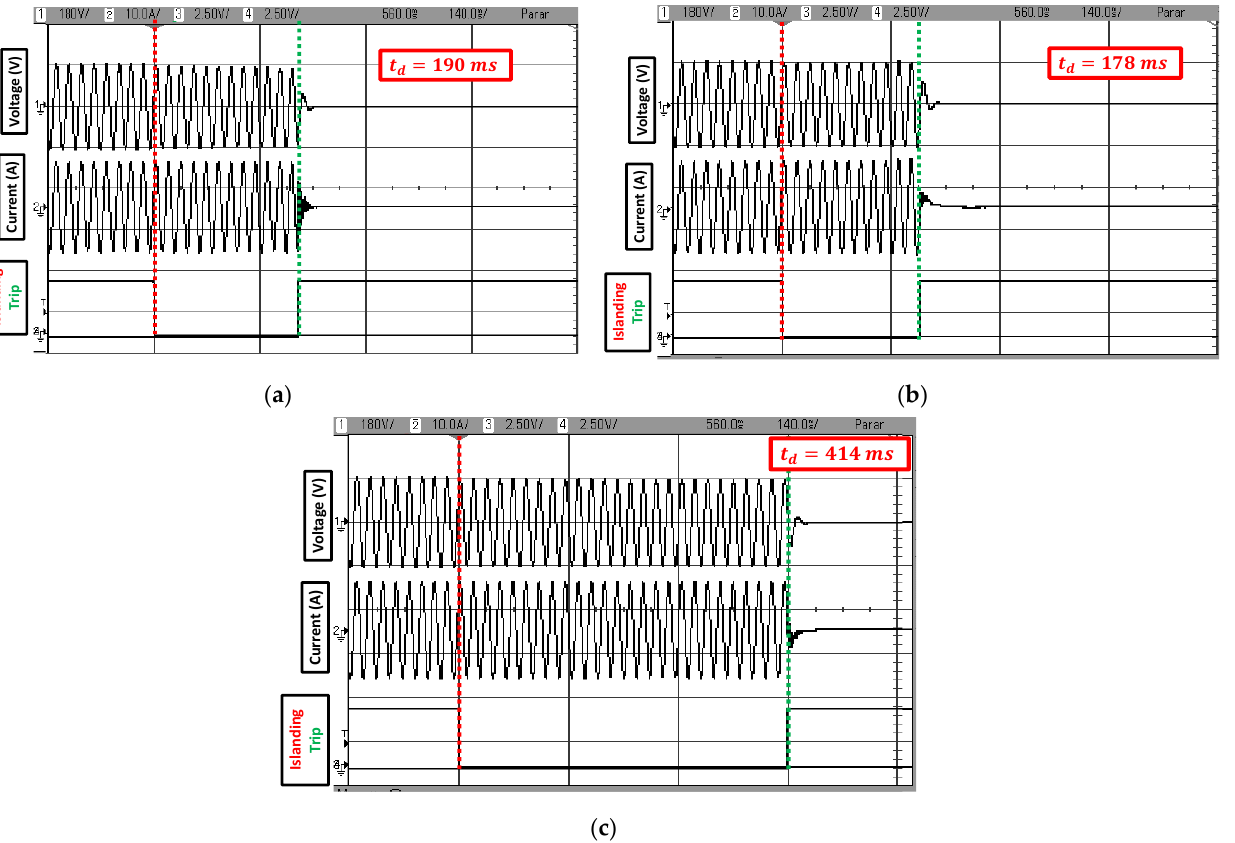
Figure 22. PCC voltage, Inverter current, Islanding, and Trip signal ( a ) under SFS implementation; ( b ) under the APJPF implementation; ( c ) under AFDPCF implementation.